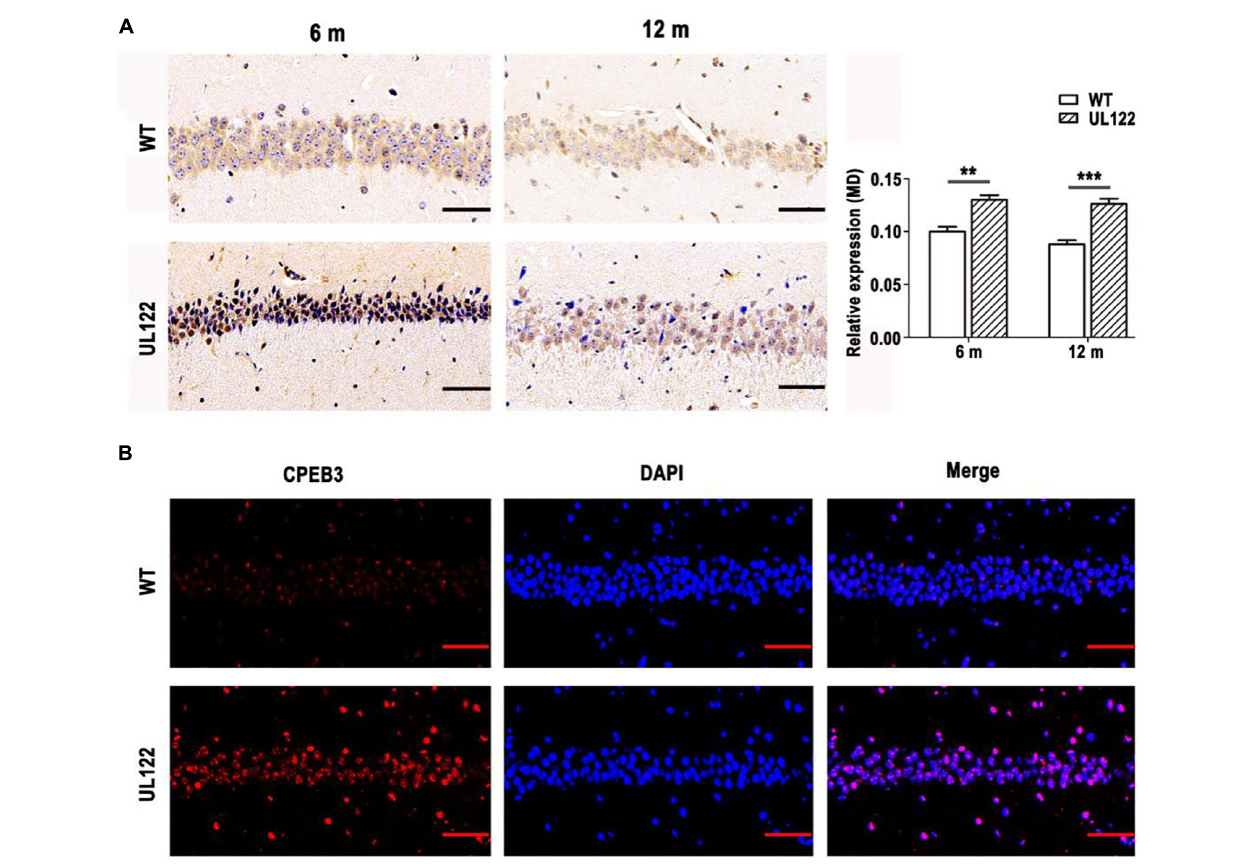
FIGURE 7 | The expression of CPEB3 in the hippocampal CA1 region of mice aged 6 and 12 months. (A) CPEB3 expressed in the hippocampal CA1 region. CPEB3 immunohistochemistry (B) . The expression of CPEB3 in the hippocampal CA1 region was measured by immunofluorescence. The bars indicate the means ± SEM ( n = 4 for each group). Statistical analysis was performed by unpaired t -test. *** P < 0.001, ** P < 0.005: significantly different from the WT group. Bar: 50 µ